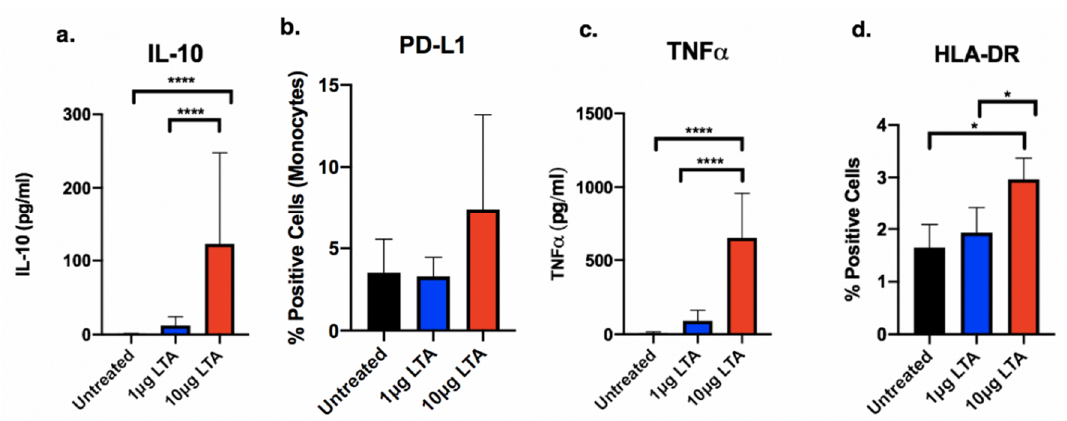
Figure 1. Effects of high (10 μg/mL) and low (1 μg/mL) exposure levels of purified S. aureus LTA on ( a ) IL-10, ( b ) PD-L1, ( c ) TNFα, and ( d ) HLA-DR expression in human PBMCs ( n = 4). Protein expression was determined using either flow cytometry (PD-L1, HLA-DR) or ELISA (IL-10, TNFα. Data are displayed as means with error bars depicting standard deviation. Brackets indicate statistical comparisons between treatments. * p < 0.05, **** p < 0.0001.